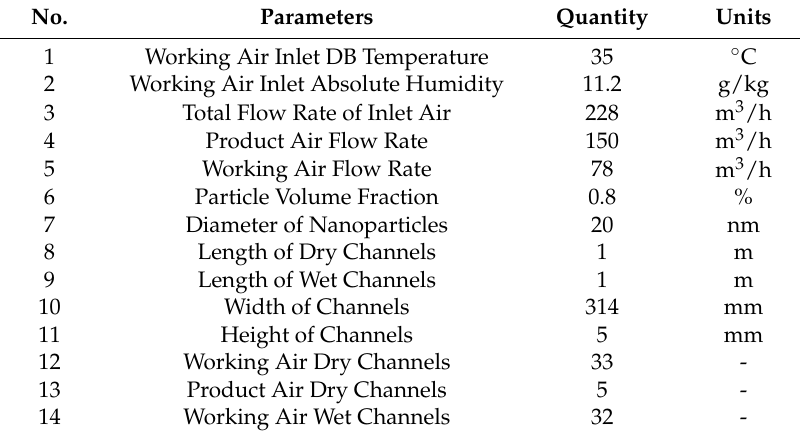
Table 7. Input parameters for the